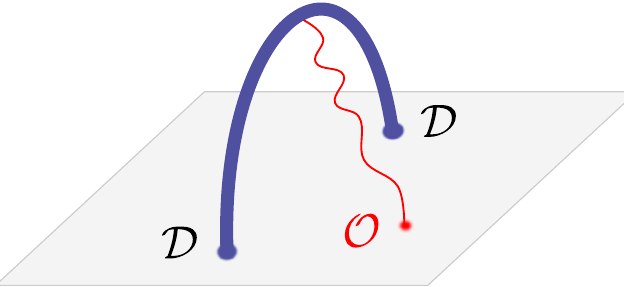
Figure 1 . The AdS description of the three-point function of two determinant operators and one single-trace operator. The determinant operators create a D-brane in the bulk which travels along the geodesics. The red wavy line represents a closed string worldsheet which gets attached to the